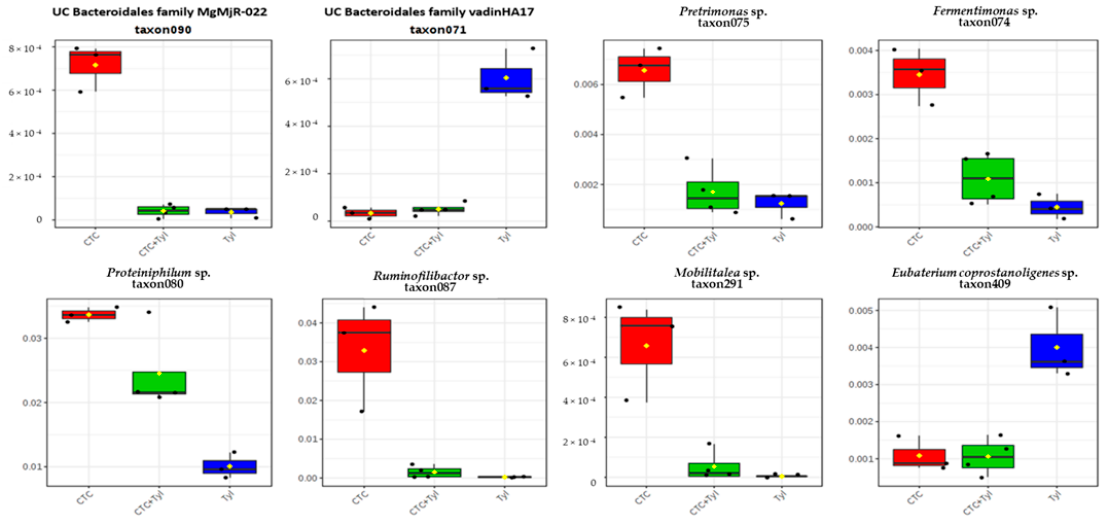
Figure 14. Box plots representing the relative abundance of 8 of the OTUs with the lowest p values.